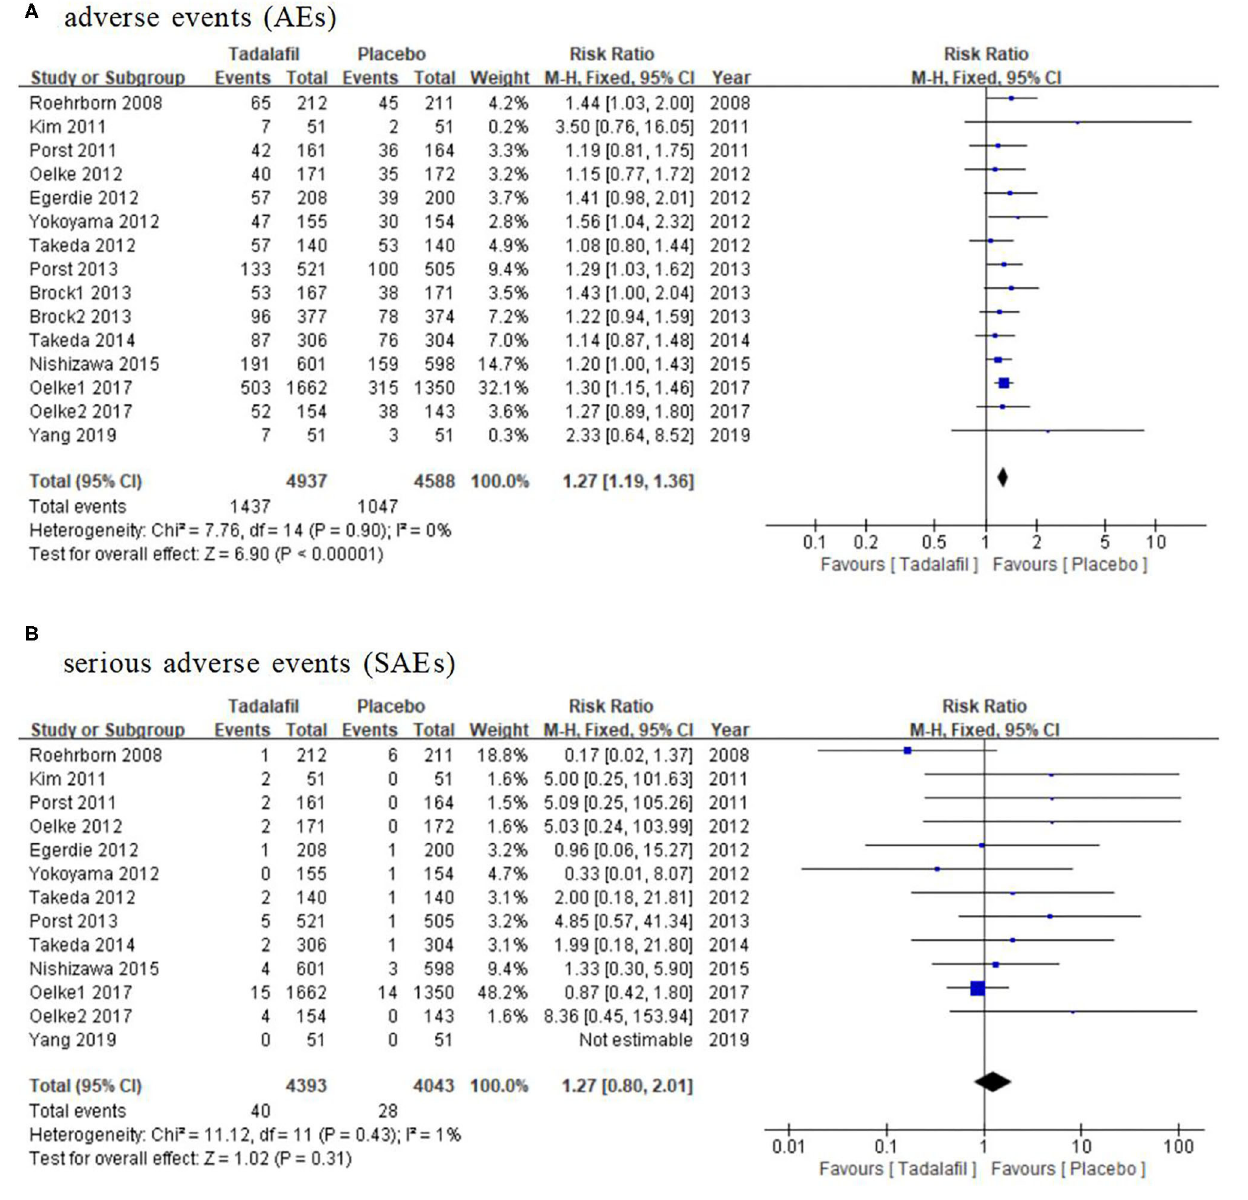
FIGURE 5 | Forest plot of (A) AE and (B) SAE. AE, adverse event; SAE, serious adverse